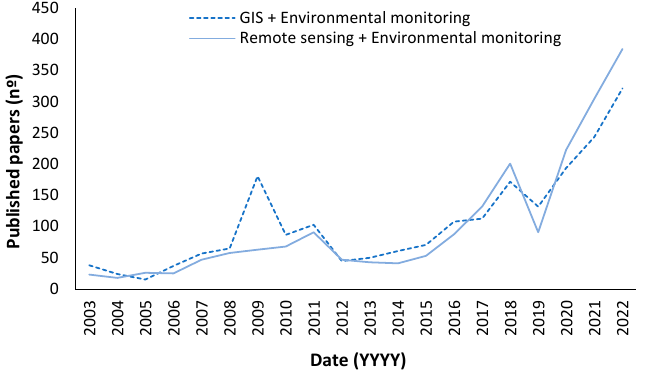
Figure 1. Published papers on the topics included over the last two decades. Note that the number of papers in 2022 was obtained at the end of July